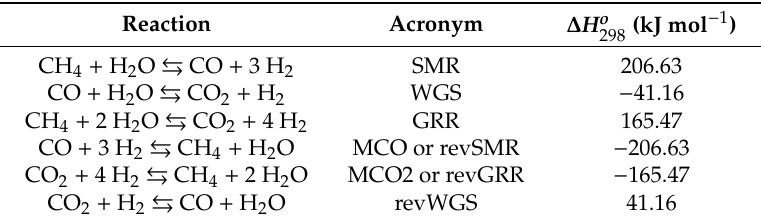
Table 1. Summary of the reactions considered in this work, with their standard reaction enthalpies, from Reference